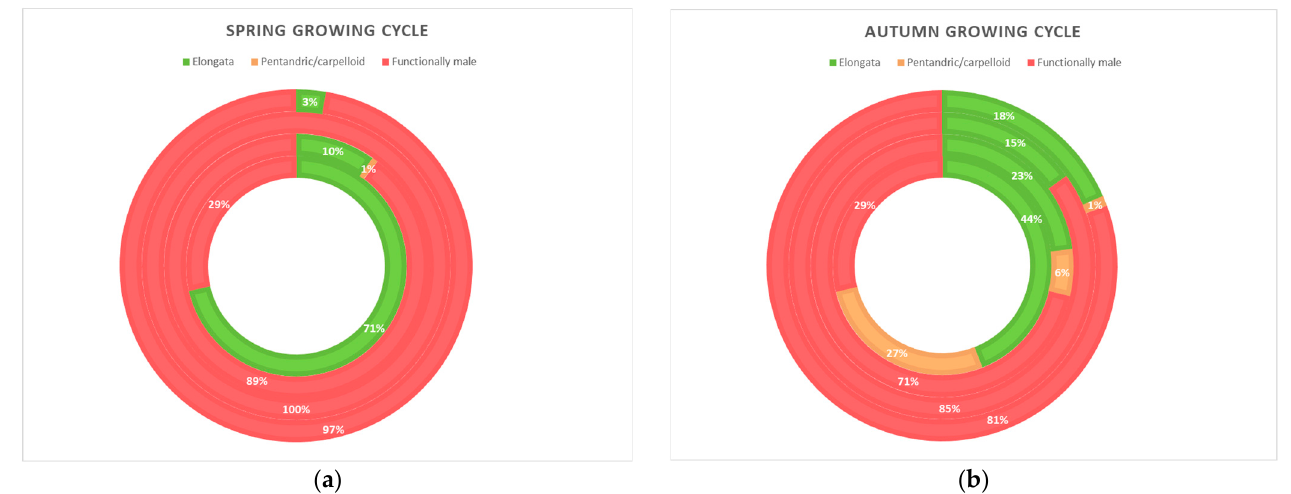
Figure 3. Seasonal frequency of elongata (green), pentandric and carpelloid (both in orange) hermaphrodite flowers, and functionally male (red) flowers found in ‘Intenzza’ papayas planted in spring ( a ) and autumn ( b ). Rings from inside to outside: spring, summer, autumn, and winter sampling dates.